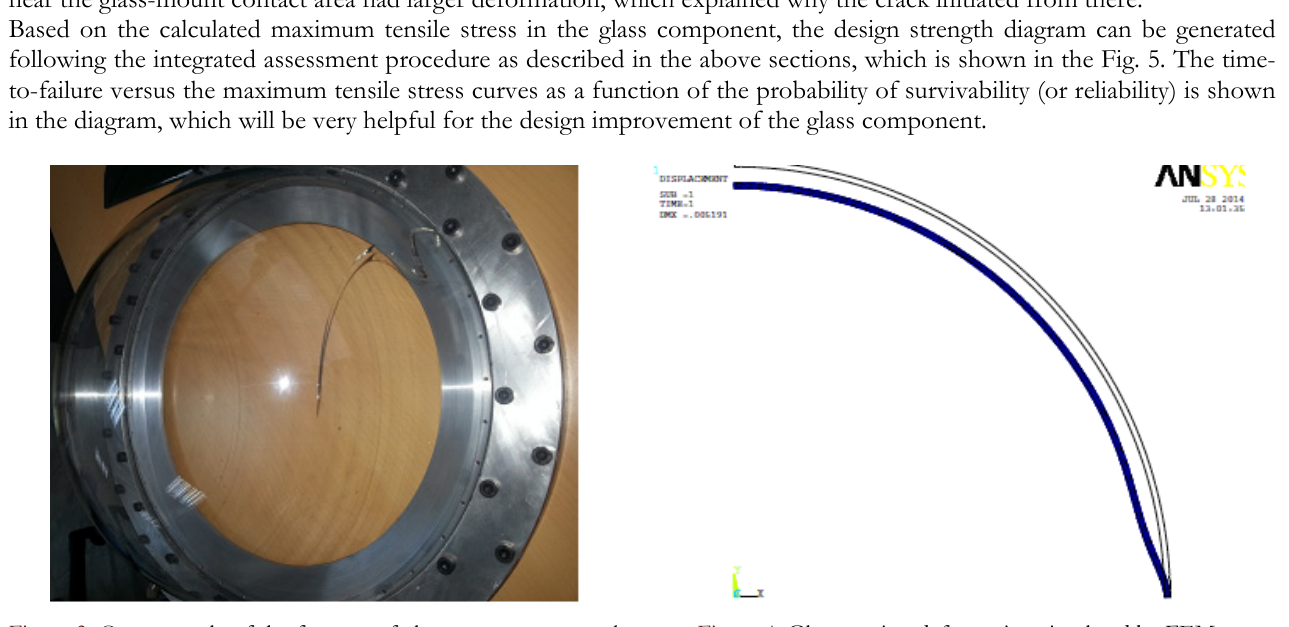
Figure 4: Glass section deformation simulated by FEM.